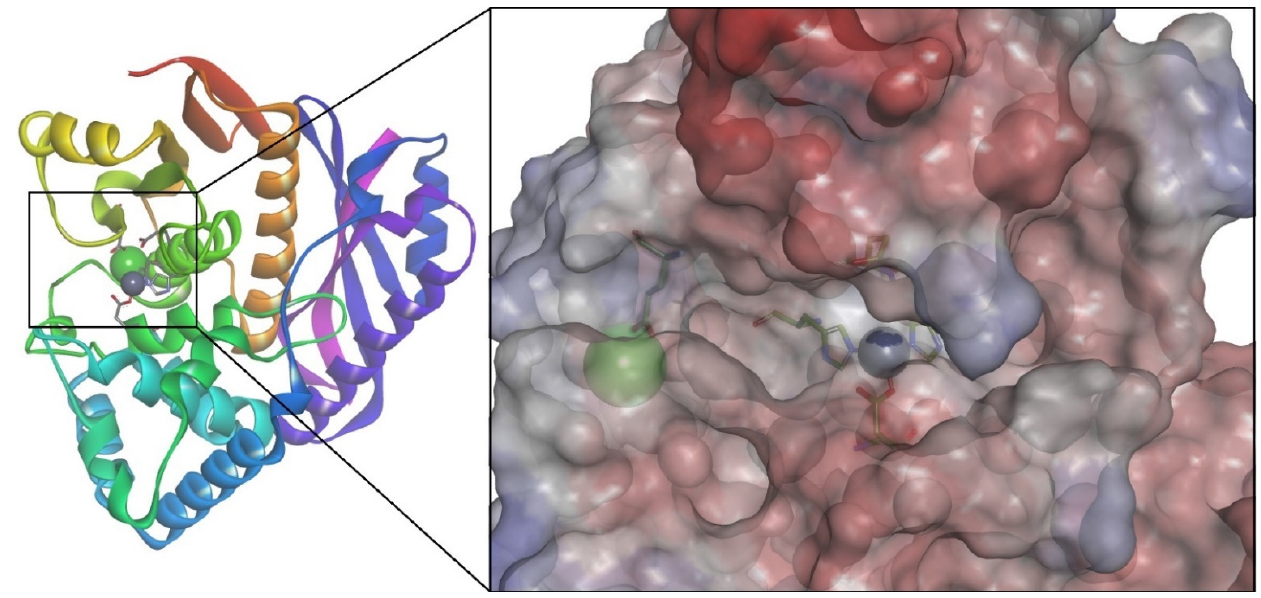
Figure 4. Predicted 3D structure of collagenase A catalytic and helper domains from C. perfringens (model S4). The surface of protease active site is colored by pKa values. Ca 2+ is depicted as a green sphere, Zn 2+ as a purple sphere, and metal-binding residues are highlighted.